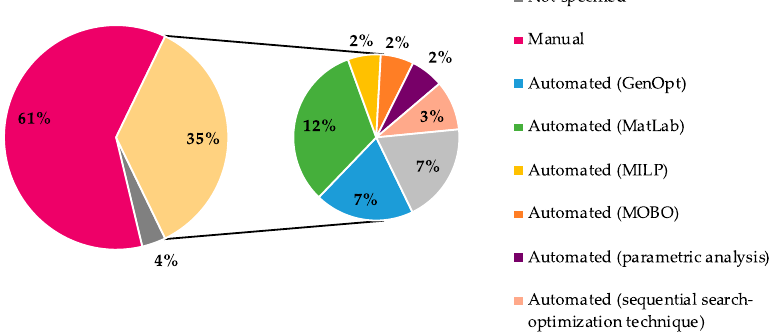
Figure 11. Methods for EEMs selection: manual (M) vs. automated (A) approach. Repartition of the analyzed papers according to the tool used.